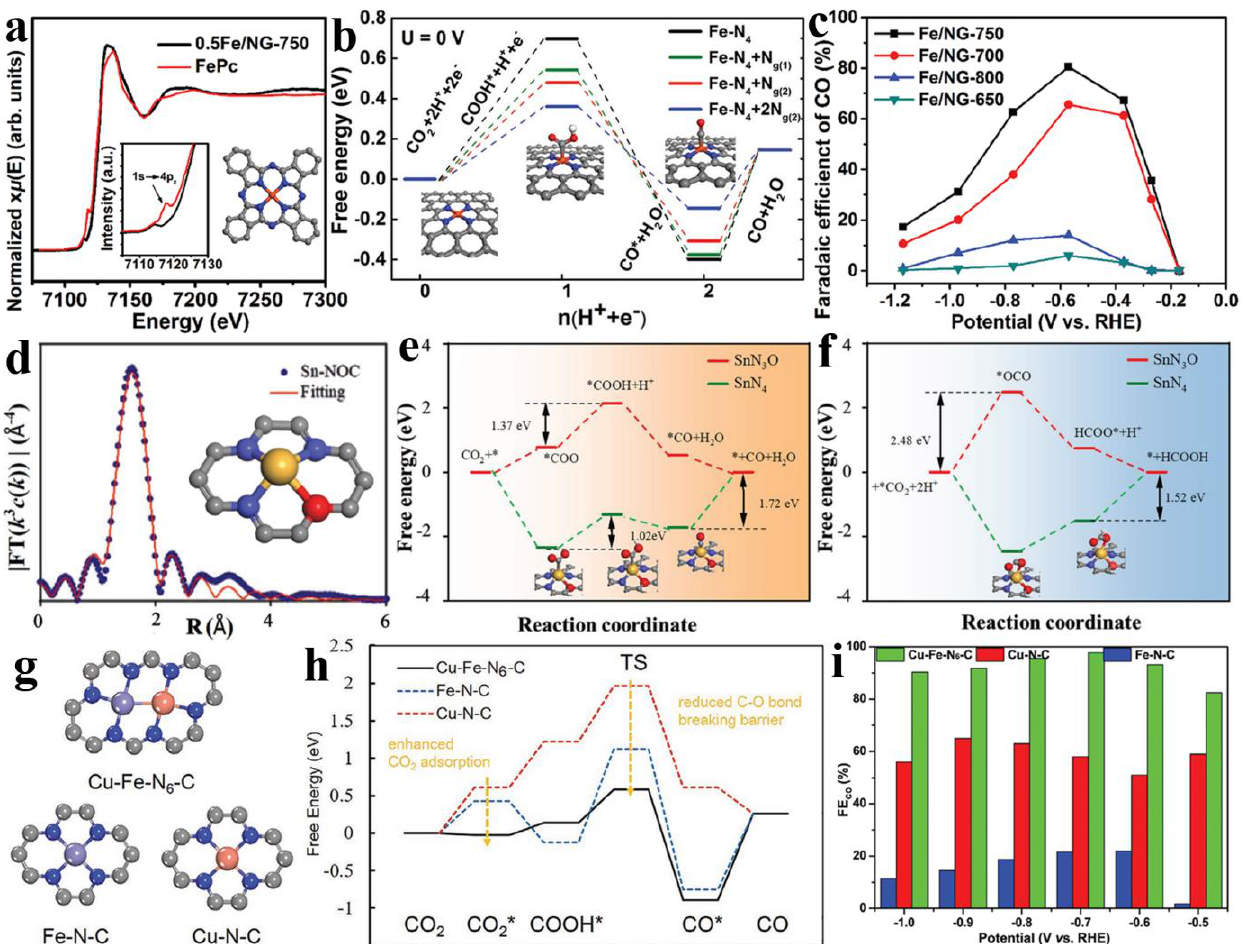
Figure 2. ( a ) Normalized Fe K-edge X-ray adsorption near-edge structure (XANES) spectra of 0.5Fe/NG-750 catalyst. ( b ) Free energy diagram for electrochemical CO 2 reduction to CO. ( c ) CO Faradaic efficiency (FE CO ). Reprinted with permission from ref. [62]. Copyright: (2018) WILEY-VCH Verlag GmbH & Co. KGaA, Weinheim. ( d ) The Fourier transform extended X-ray absorption fine structure (FT-EXAFS) fitting curve for Sn-NOC in R space. The calculated Gibbs free energy diagrams for ( e ) CO 2 -to-CO conversion and for ( f ) CO 2 -to-HCOOH conversion. Reprinted with permission from ref. [64]. Copyright: (2021) The Authors. Advanced Science published by Wiley-VCH GmbH. ( g ) Atomic models of Cu-Fe-N 6 , Fe-N 4 , and Cu-N 4 catalytic centers. ( h ) Free energy profiles for CO 2 electroreduction reactions. ( i ) FE CO of Fe-N-C, Cu-N-C, and Cu-Fe-N 6 -C. Reprinted with permission from ref. [65]. Copyright: (2020) Wiley-VCH